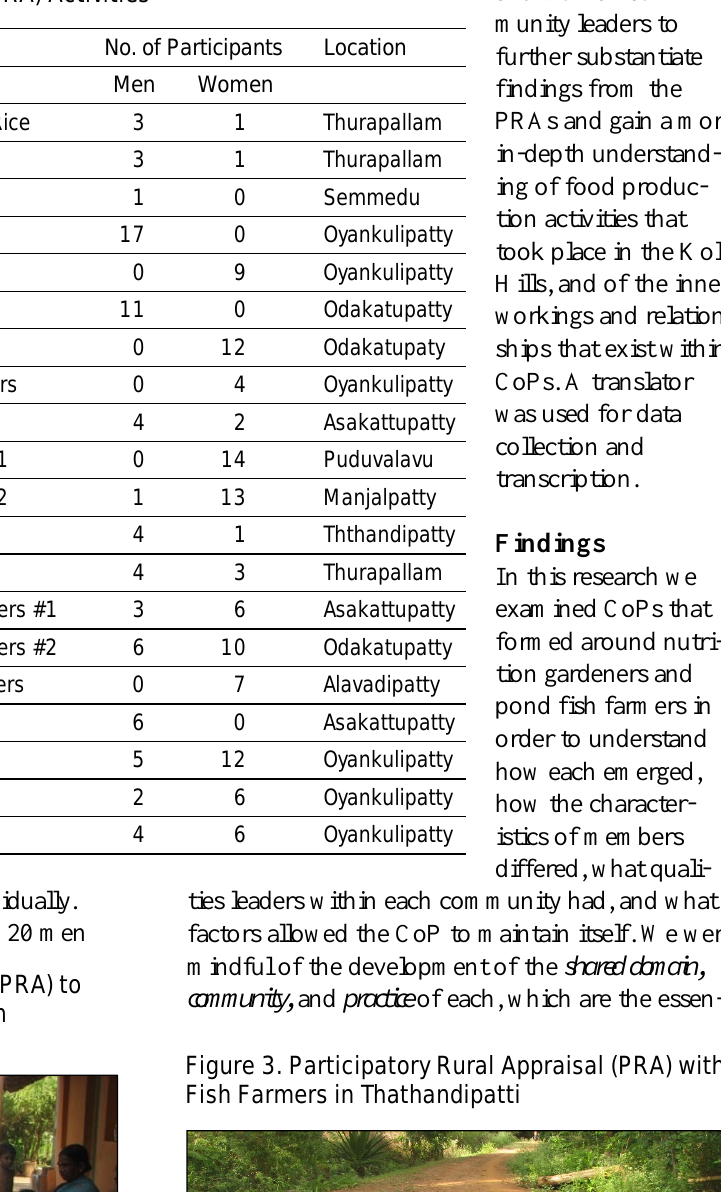
Table 2. Participatory Rural Appraisal (PRA) Activities